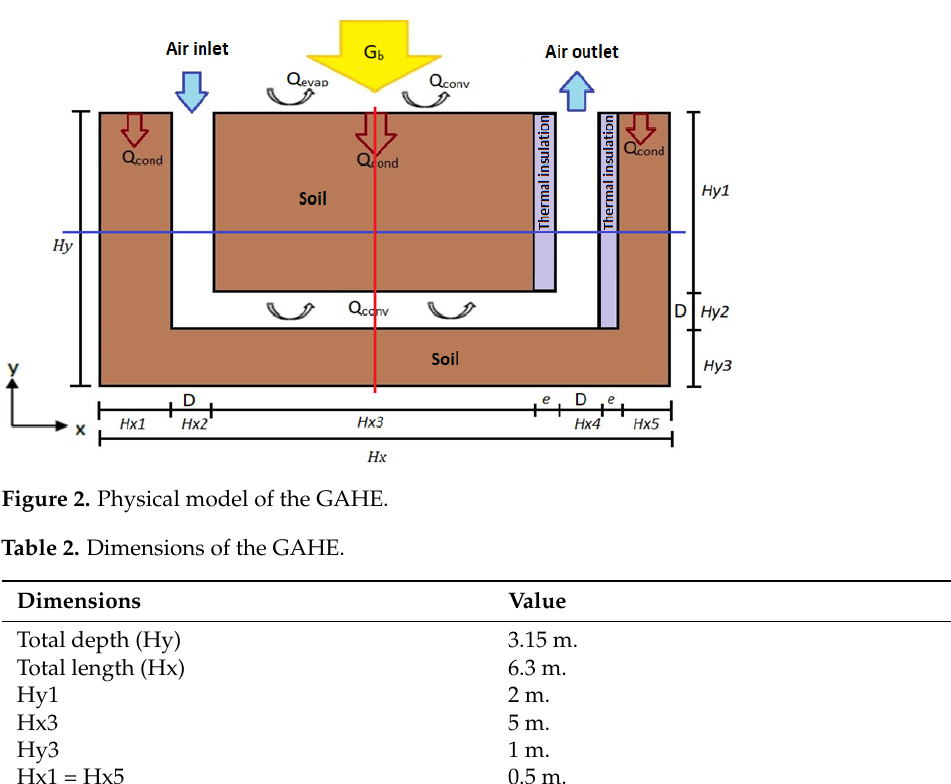
Table 2. Dimensions of the GAHE. Dimensions Value